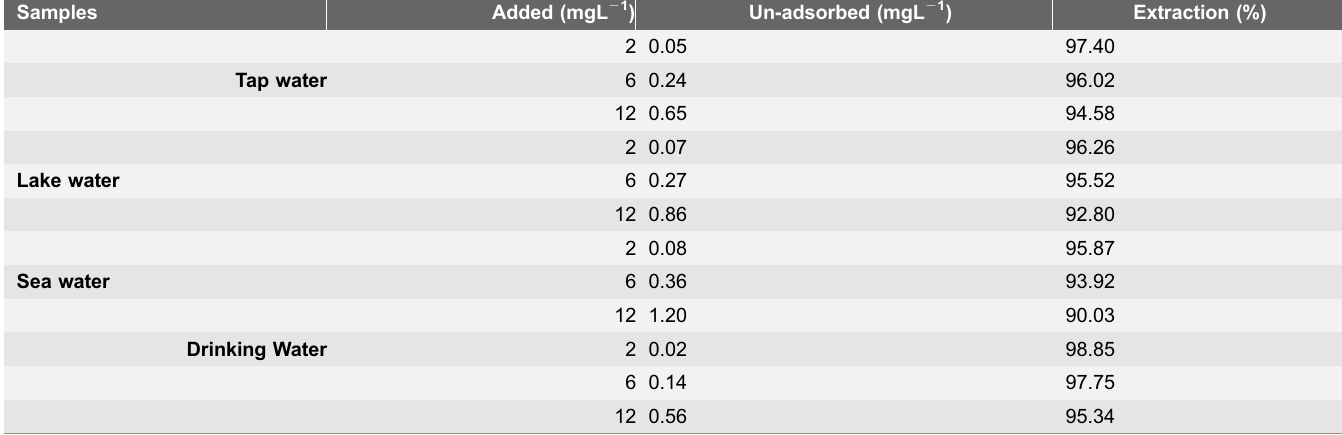
Table 4. Determination of Co(II) at different concentrations in real water samples using 25.0 mg Ag 2 O 3 -ZnO NCs ( N 5 3).